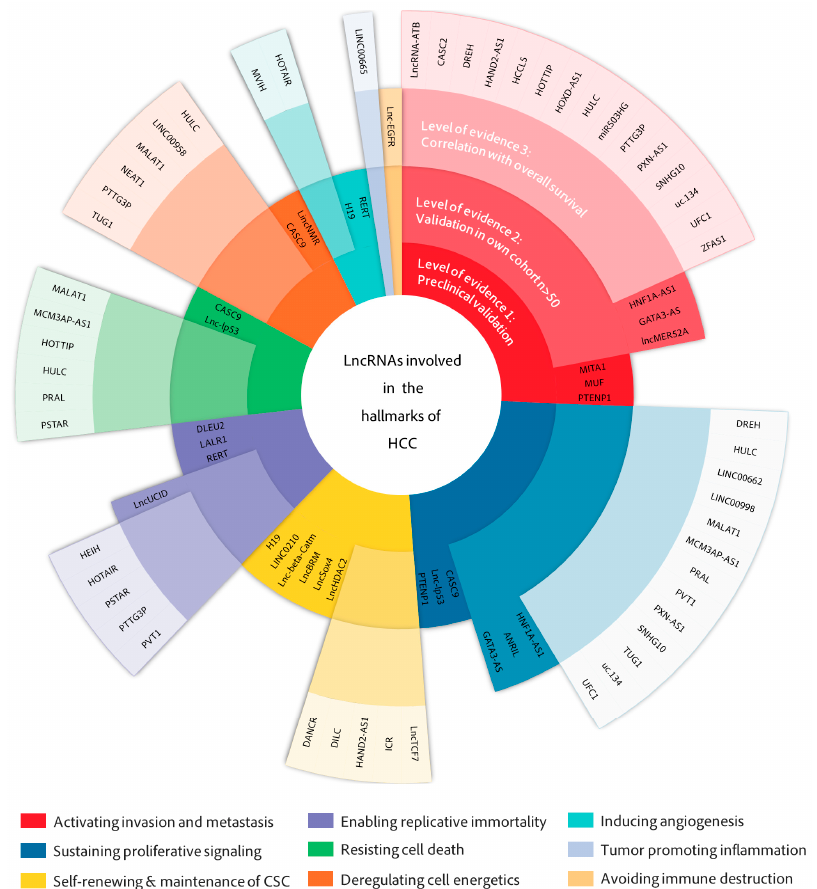
Figure 3. Degree of in vivo validation of HCC lncRNAs stratified according to hallmarks of cancer. LncRNAs described in Figure 1 and classified according to the hallmarks of cancer they modulate have been stratified in three steps called “levels of evidence” of their clinical relevance. Level 1 requires preclinical validation in model animals and has been done for all cases. Level 2 indicates that lncRNA expression and/or clinical associations have been studied in at least two independent cohorts of patients ( n > 50). Level 3 is granted when the expression of the lncRNA has a significant association with overall survival.